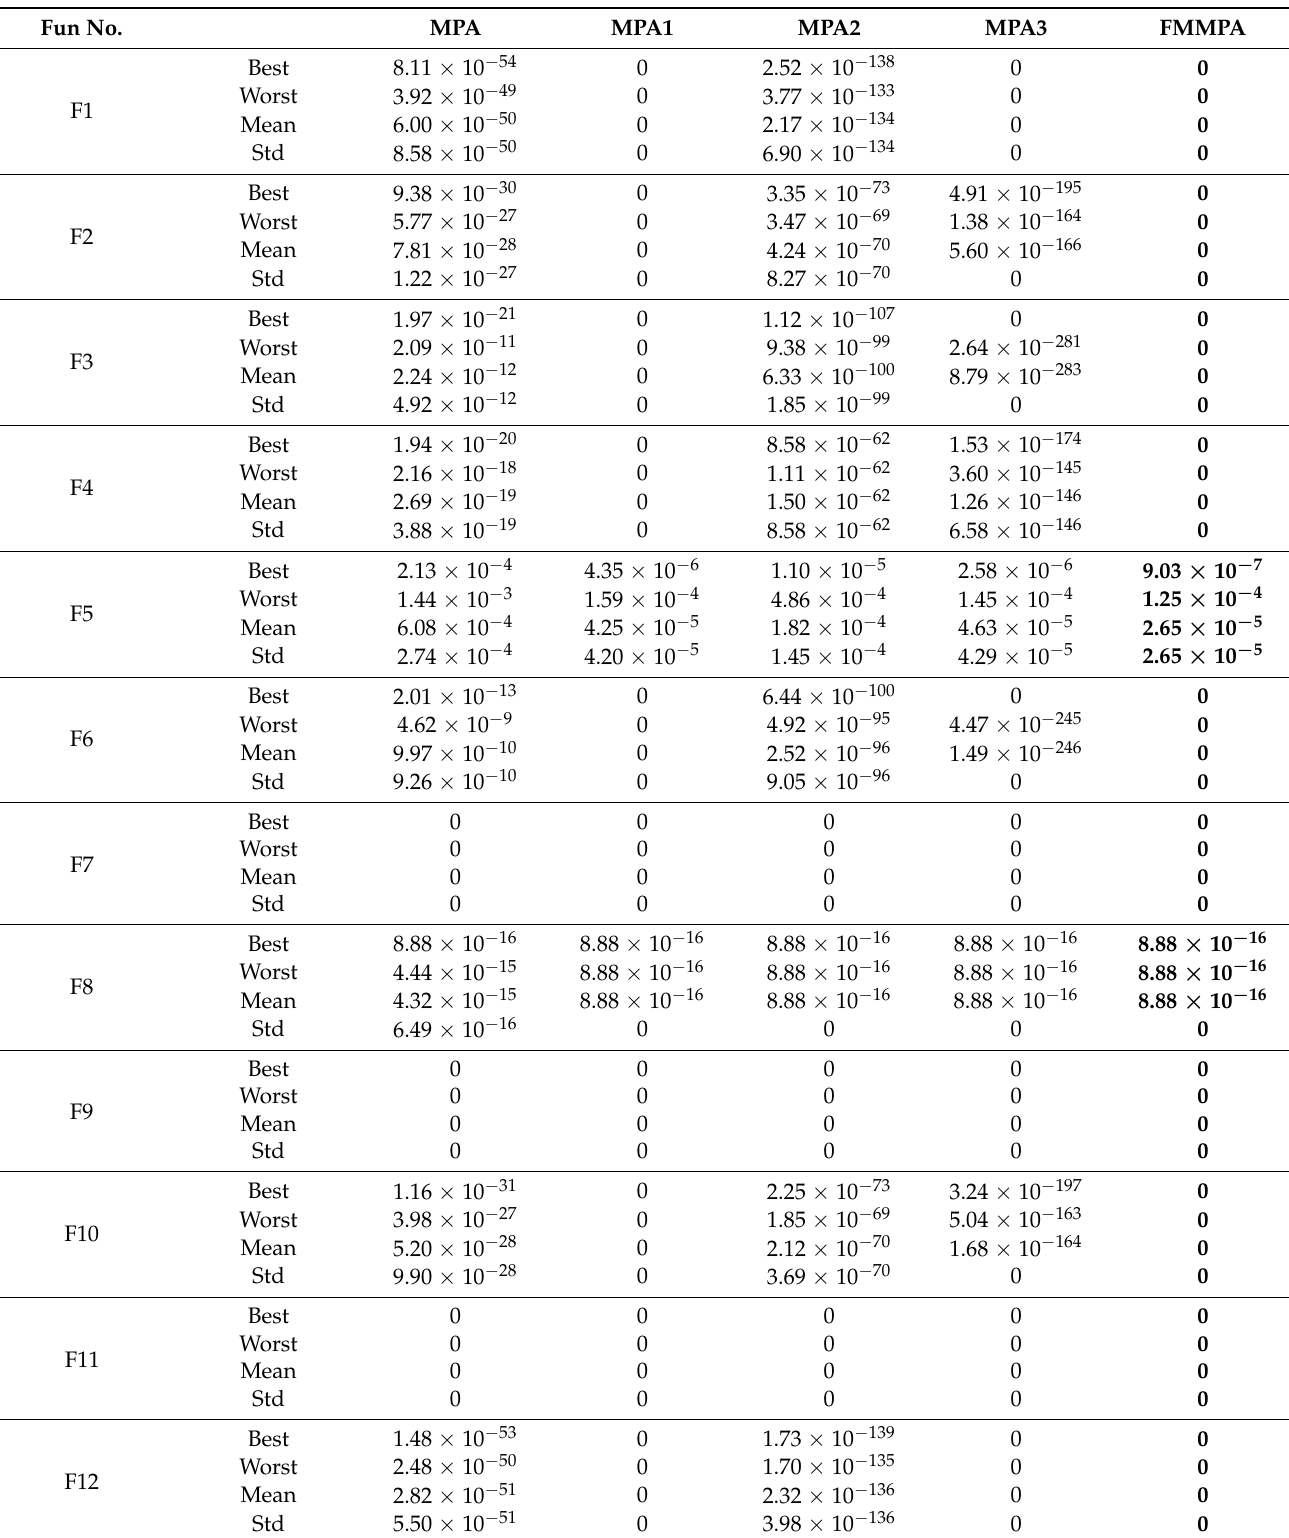
Table 4. Comparison results of FMMPA and improved MPA on 16 test